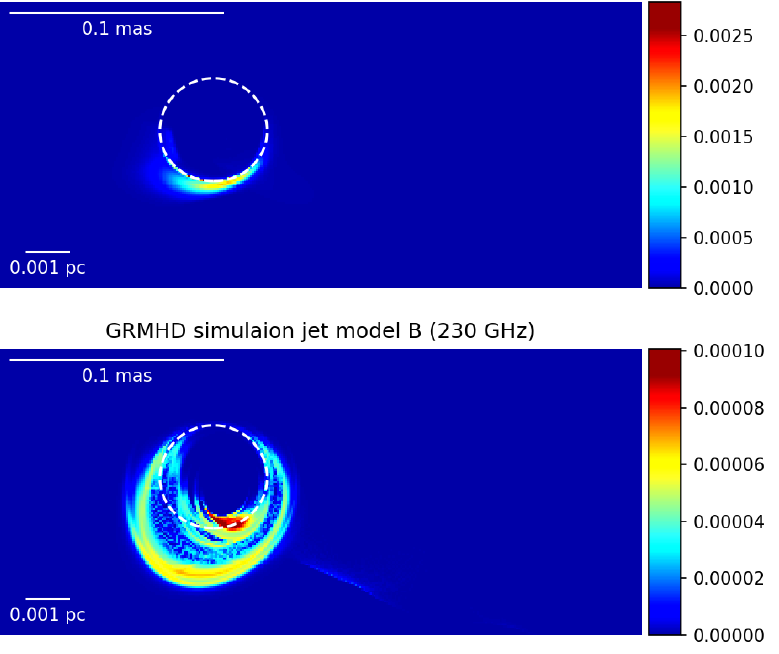
Figure 7. Model synchrotron images at 230 GHz for GRMHD jet models A and B. The images are shown on a linear scale. For reference, the size of the black hole shadow is indicated by the dashed white circle.